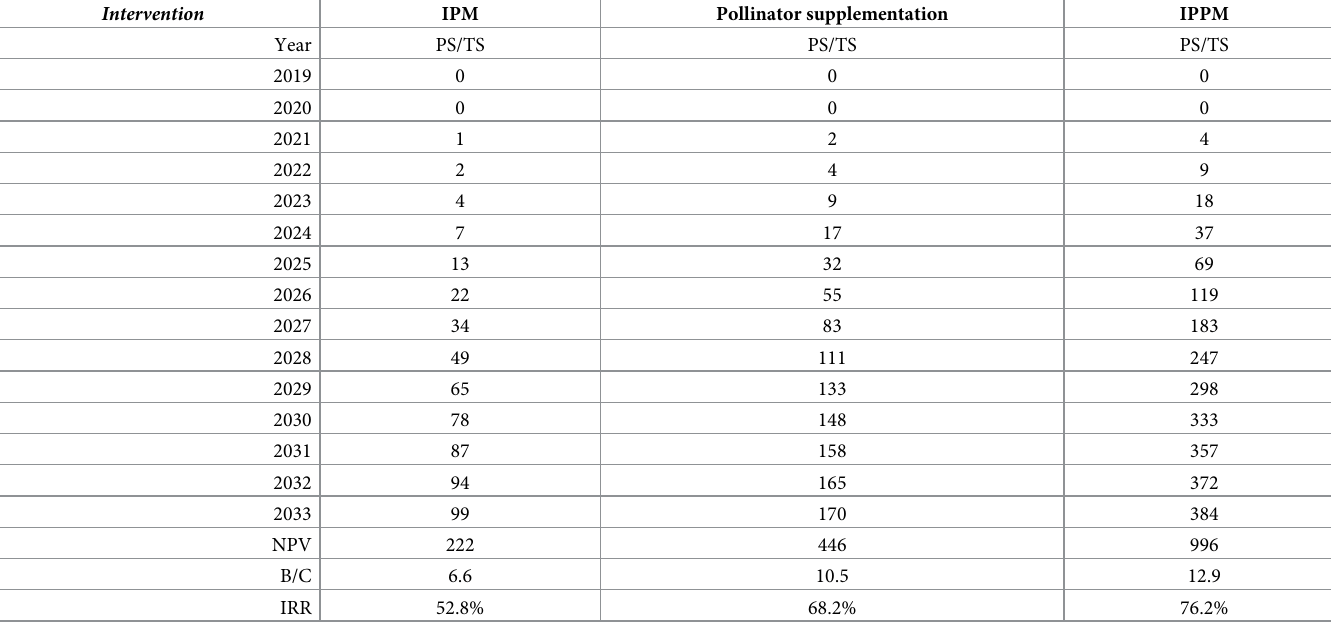
Table 2. Total economic benefits of adopting IPM, pollinator supplementation, and IPPM in avocado production in Kenya in (‘Million US$). Intervention